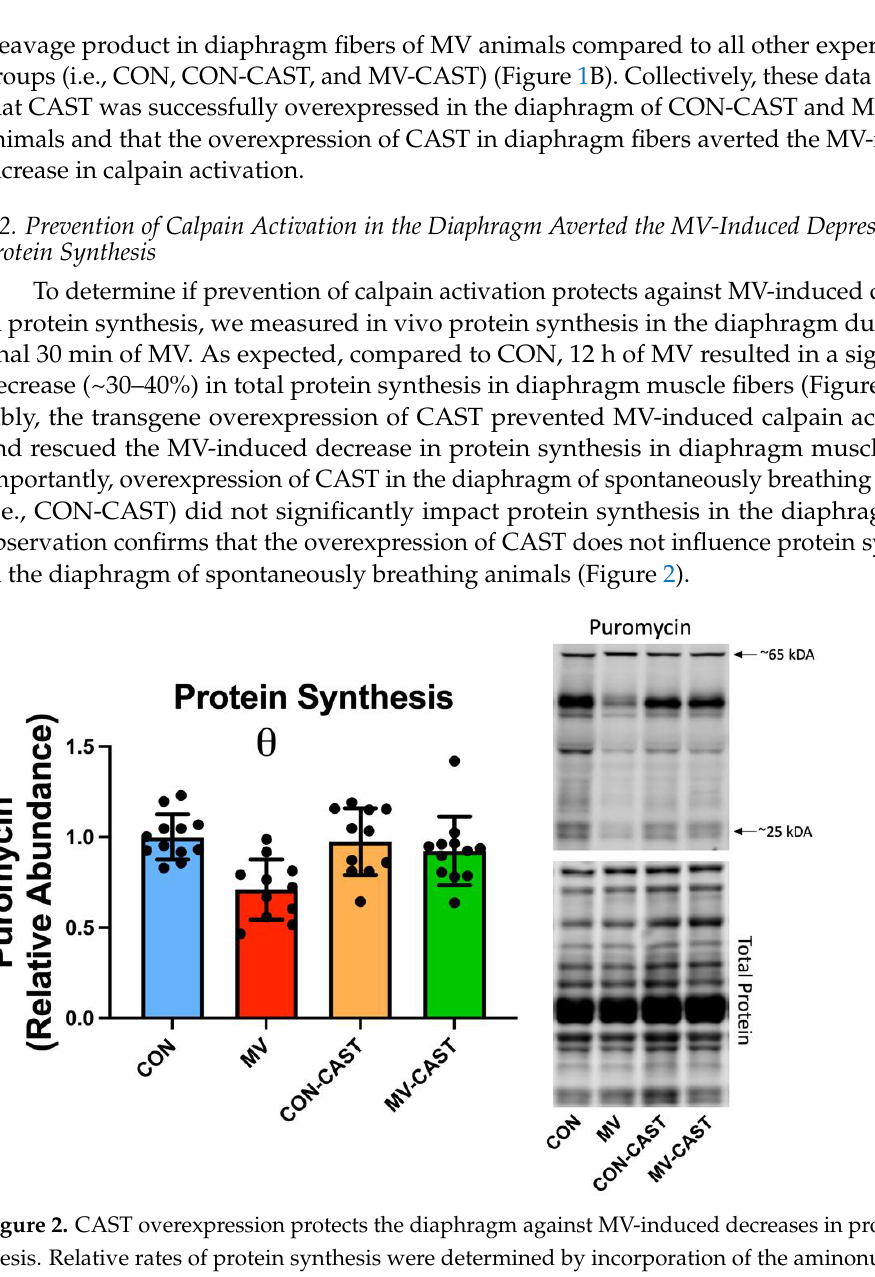
Figure 2. CAST overexpression protects the diaphragm against MV-induced decreases in protein synthesis. Relative rates of protein synthesis were determined by incorporation of the aminonucleoside puromycin into polypeptide chains. θ = MV is significantly different from CON, CON-CAST, and MV-CAST.